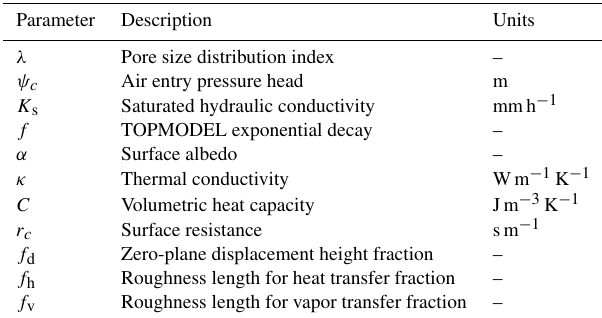
Table 1. The model parameters that need to be